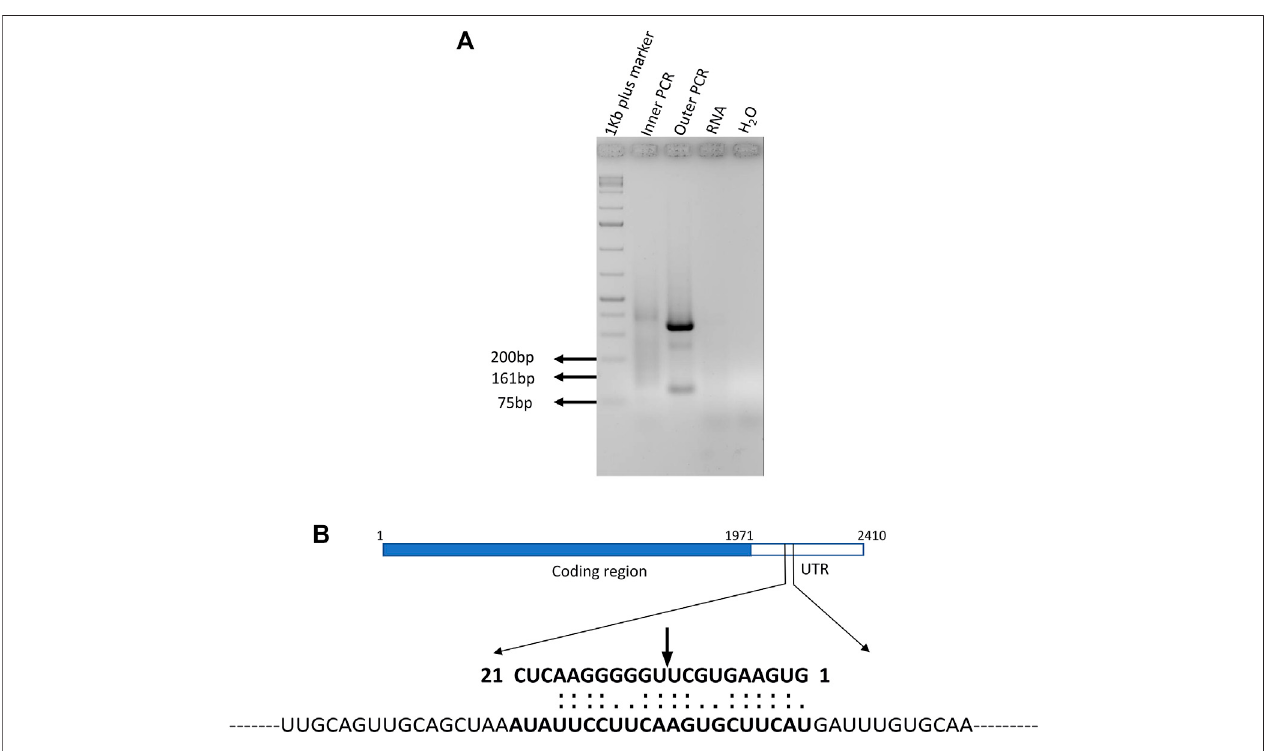
FIGURE 10 | MiR395a putative target gene pentatricopeptide 5 ′ RLM-RACE and psRNAtarget-predicted binding region. (A) 5 ′ RLM-RACE was performed with adapter and gene-speci fi c primers and the expected product of 161 bp was observed in inner PCR. (B) psRNAtarget predicted the miR395a-binding region on the pentatricopeptidemRNAsequencewhichshowsmiR395abindsatthe2155 – 2175 ntregionofthePPRmRNA,and thepossible cleavagesiteispresent between10th and 11th